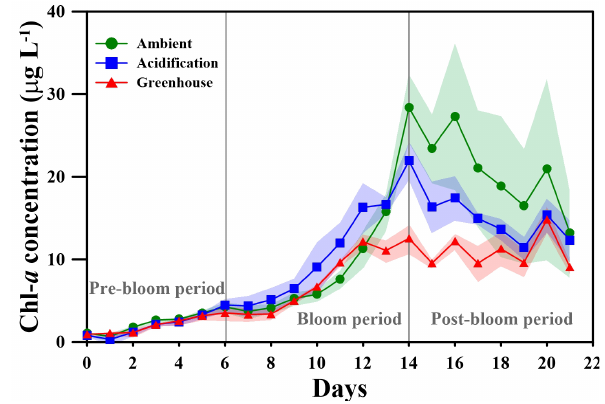
Fig. 1. Autotrophic phytoplankton biomass (Chl a concentration) during the experimental period under the ambient (green), acidifi- cation (blue), and greenhouse (red) treatment conditions. Colored shading represents the standard deviation from the mean (colored symbols and lines) of the replicate enclosures ( n =